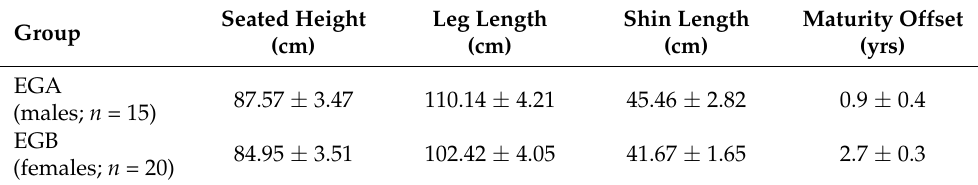
Table 2. Mean ± SD of the anthropometric measurements ( n = 15).